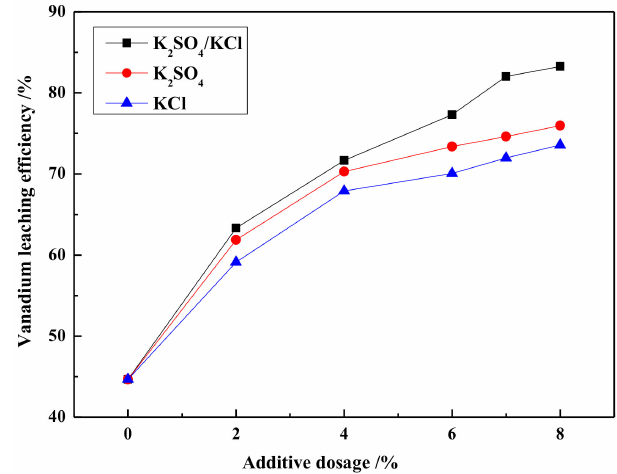
Figure 3. Effect of additive dosage on vanadium leaching efficiency.